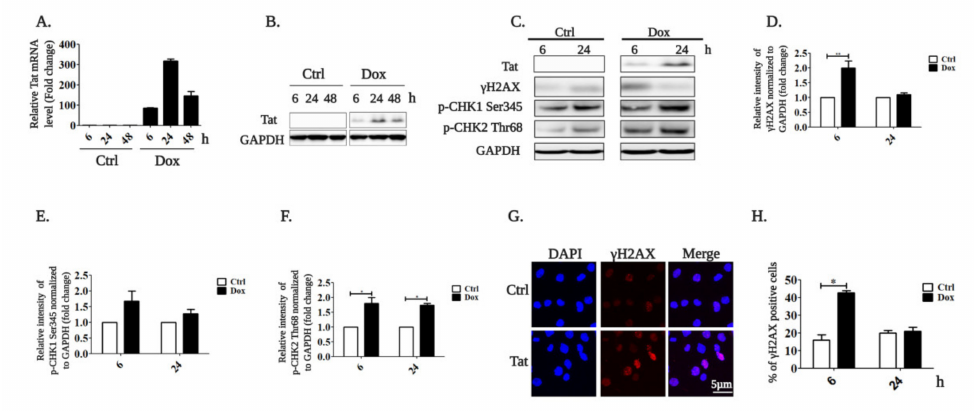
Figure 1. HIV-1 Tat induces DNA damage in B cells. ( A ) Doxycycline-inducible Tat-expressing RPMI- 8866 cells were treated (Dox) or not (Ctrl) with 1 µ g/mL doxycycline for 6, 24 and 48 h. Tat expression was analyzed using qRT-PCR and quantified by the 2 − ∆∆ ct method comparing the expression of the target gene in cells treated with Dox with the untreated control (set as 1) after normalization with GAPDH gene expression. ( B ) Doxycycline-inducible Tat-expressing RPMI-8866 cells were treated as in ( A ) for 6 and 24 h. Tat expression was identified with an appropriate antibody. ( C ) RPMI-8866 cells were treated as in ( A ) and analyzed 6 and 24 h after induction. Tat, γ -H2AX and p-CHK2 Thr68 were detected by Western blotting with appropriate antibodies. ( D ) Intensities of γ -H2AX, ( E ) p-CHK1 Ser345 and ( F ) p-CHK2 Thr68 bands were quantified with ImageJ software in Dox-treated cells compared to the untreated control (set as 1) after normalization with GAPDH band intensities, which was used as the loading control. ( G ) γ H2AX was immuno-stained in doxycycline-inducible Tat-expressing RPMI-8866 cells treated as in ( A ) for 6 h. Nuclei stained with DAPI are in blue, and γ -H2AX staining is shown in red. ( H ) Images from D were analyzed using the ImageJ software to evaluate the percentage of cells with the γ H2AX staining. All data represent the results of three independent experiments and are expressed as the mean ± SEM. The statistical significance was calculated vs. untreated controls; * 0.01 < p < 0.5, ** 0.001 < p <